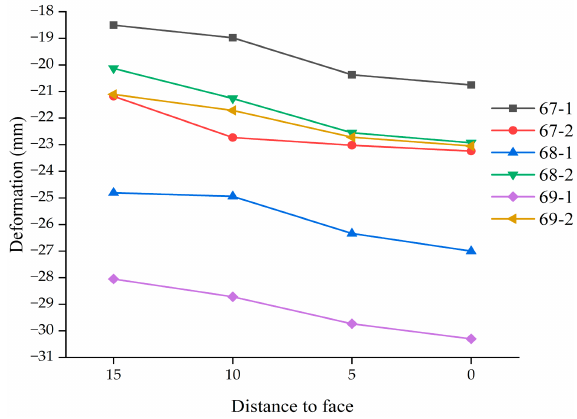
Figure 14. Surface deformation at monitoring points.